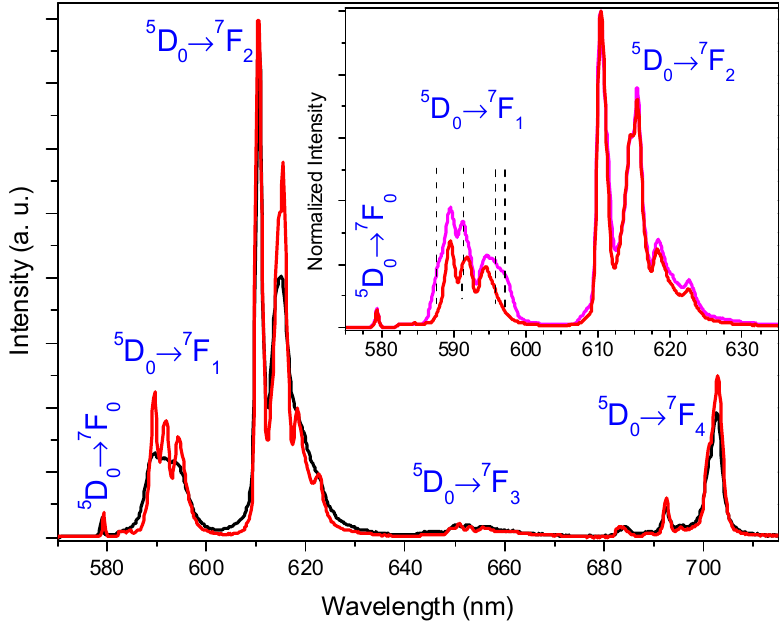
Figure 8. Emission spectra of [Eu 7 (H 5 btp) 4 (H 5.5 btp) 2 (H 6 btp) 2 (H 2 O) 12 ] · 23.5H 2 O · MeOH ( 1Eu ), recorded at ambient temperature (black line) and at 12 K (red line), with the excitation fixed at 393 nm. The inset shows the Eu 3 + 5 D 1 → 7 F 0,1,2 transitions region recorded at 12 K using excitation wavelengths of 393 (red line) and 310 nm (magenta line).